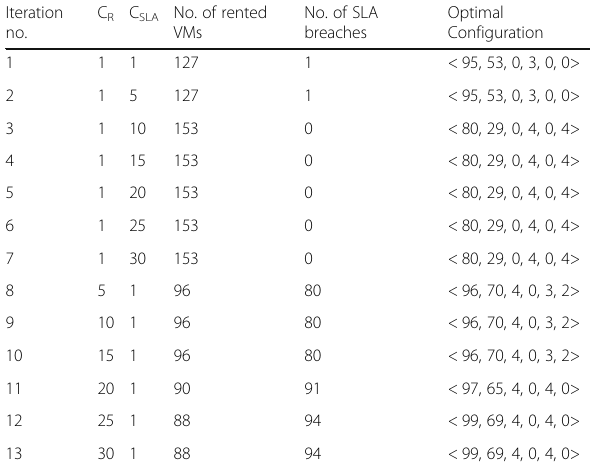
Table 18 The genetic algorithm behavior in an environment with the growing workload Iteration no.